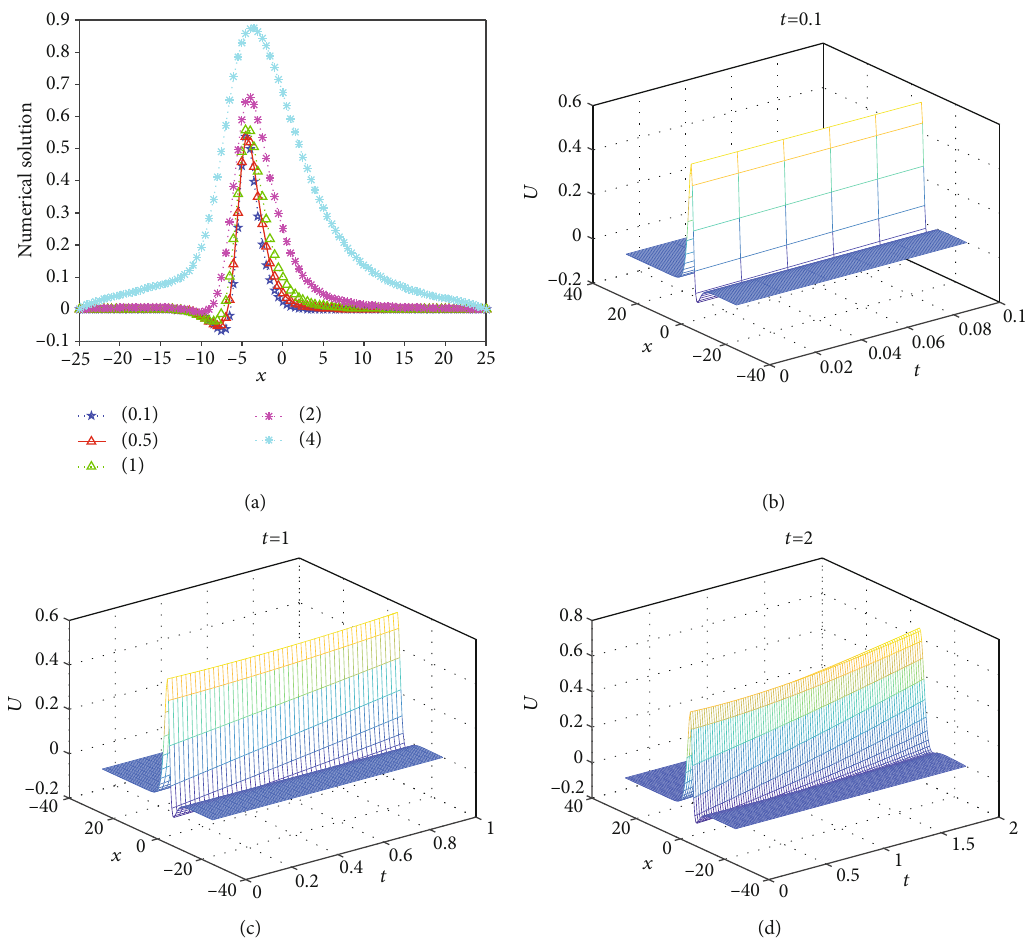
Figure 1: Using scheme (28) – (30), curves of u ð x , t Þ with respect to x at di ff erent time with h = 0 : 5 , τ = 0 : 02 (a) and the evolutionary surfaces of u ð x , t Þ at T = 0 : 1 (b), T = 1 (c), and T = 2 (d) in Example